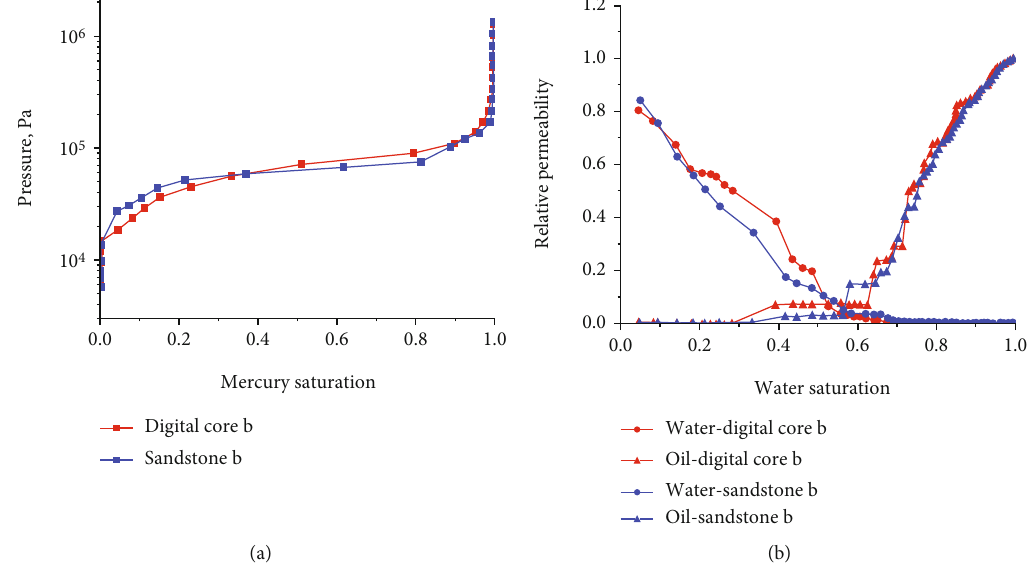
Figure 21: (a) Mercury injection and (b) oil-water two-phase fl ow simulation of digital core b and sandstone